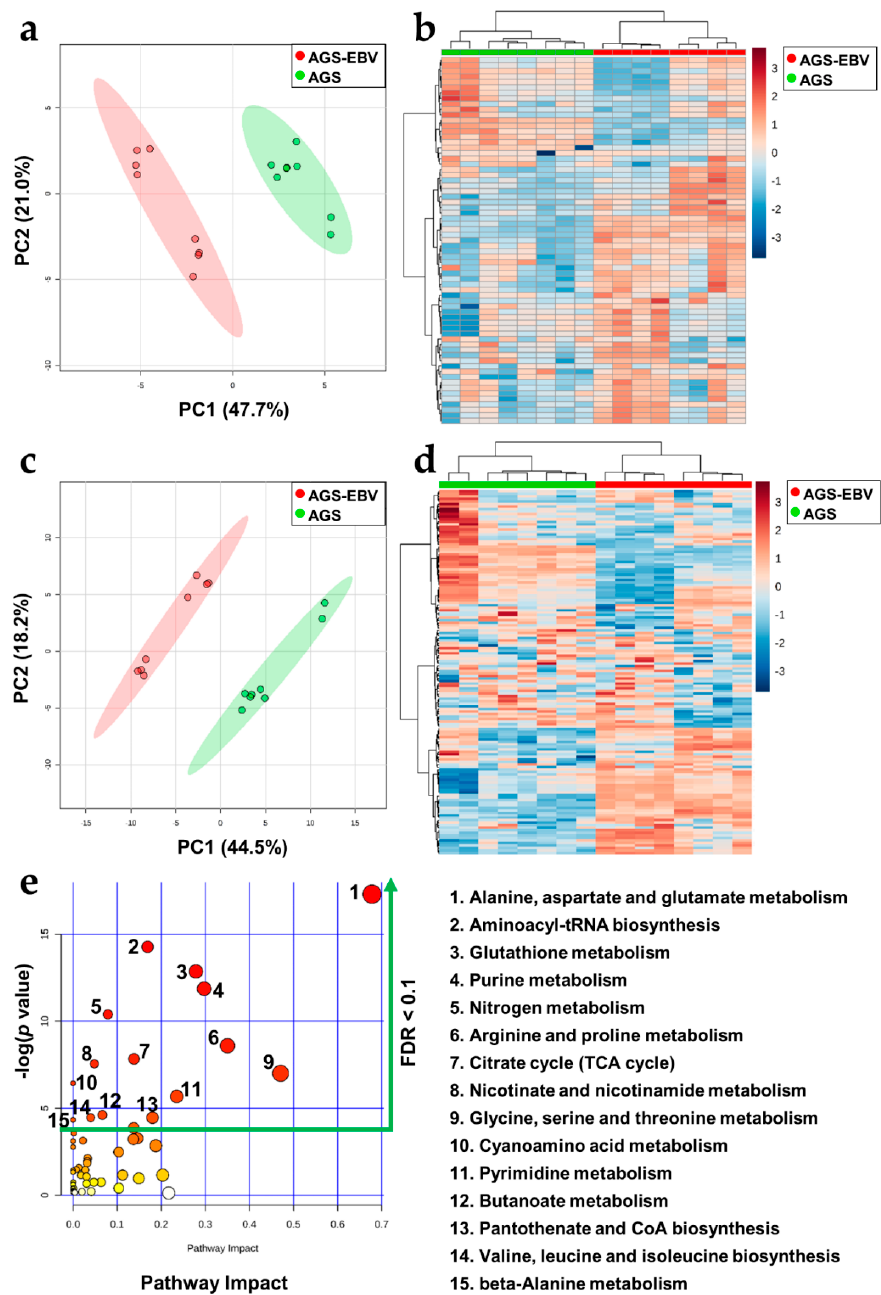
Figure 3. Metabolic profiles of AGS-EBV and AGS made using gas chromatography–mass spectrometry (GC-MS) and high-performance liquid chromatography coupled with triple quadrupole mass spectrometry (HPLC-QqQ MS). ( a ) Two-dimensional (2D) score plot derived using the untargeted GC-MS method showed a tendency of di ff erence between the AGS-EBV and AGS cell lines. ( b ) The heatmap derived from GC-MS-based analysis showed a marked contrast in the expression of the detected metabolites between AGS-EBV and AGS. Also, the ( c ) 2D score plot derived from the HPLC-QqQ MS method and ( d ) heatmap also derived from the large-scale, targeted HPLC-QqQ MS method showed apparent di ff erences between the AGS-EBV and AGS cell lines. ( e ) The pathway analysis based on polar metabolites di ff erentially expressed between AGS-EBV and AGS suggests that 15 metabolic pathways are significantly ( p -value < 0.05, FDR < 0.1) associated with the e ff ect of EBV infection on gastric